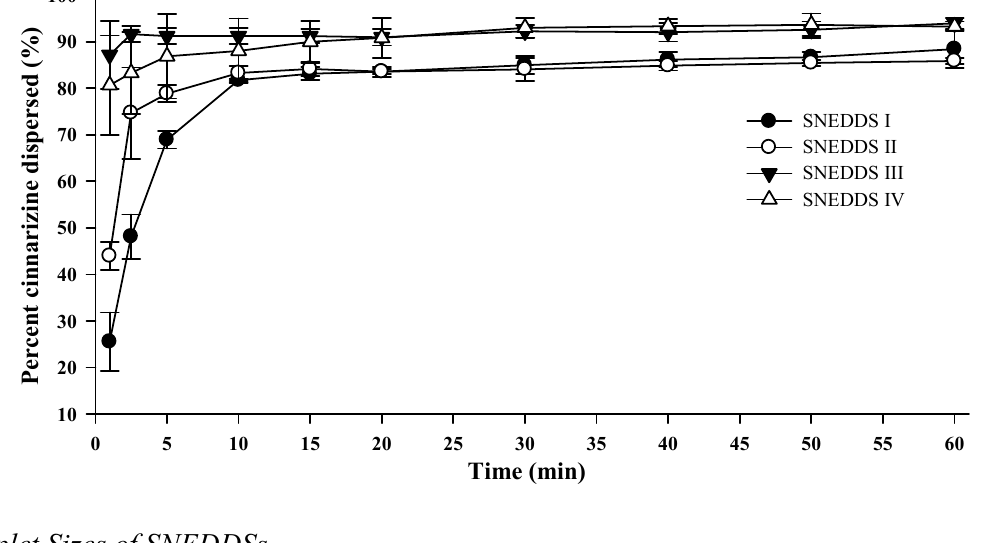
Figure 4. Dispersion of cinnarizine during dispersion of 1 g SNEDDS containing 25 mg cinnarizine per gram in fasted state simulated gastric fluids at pH 1.6 and 37 °C ( n =